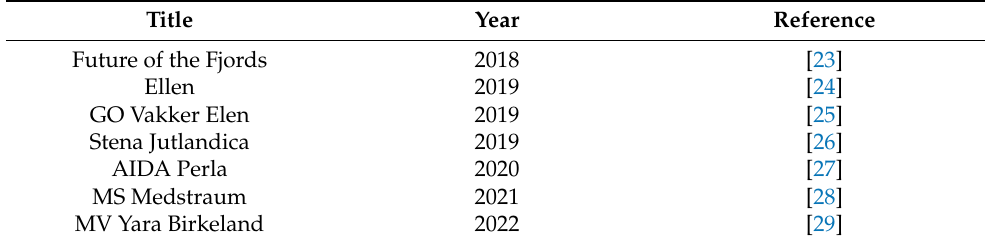
Table 2. Projects to apply batteries propulsion into the marine sector.